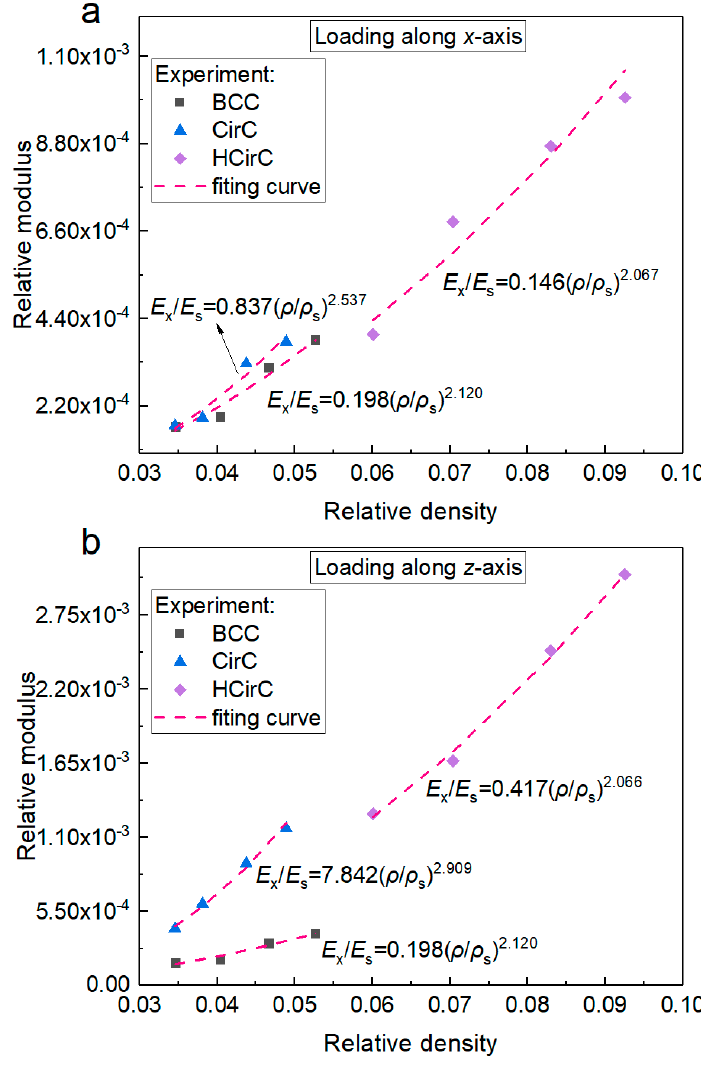
Figure 13. The relationship between relative density and relative stiffness for the BCC, CirC, and HCirC is along two loading directions: ( a ) compression direction is along the x -axis; ( b ) compression direction is along the z -axis.